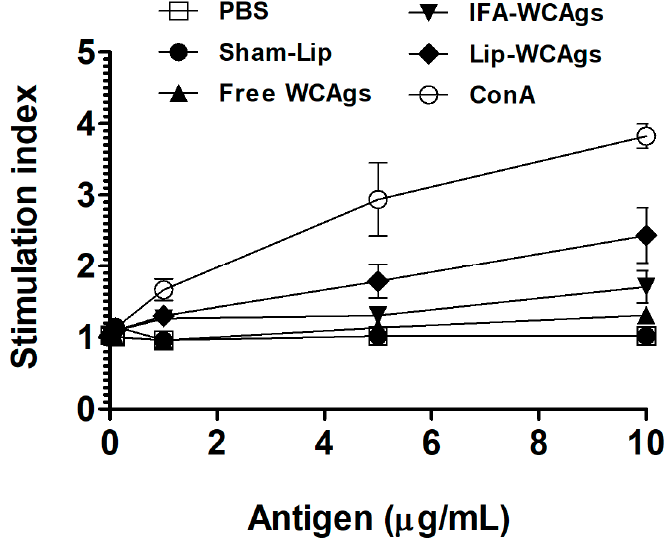
Figure 3. The splenocytes from Lip-WCAgs-immunized mice demonstrated the greatest prolifera- tion in response to WCAgs. The values are expressed as the mean ± SD of three